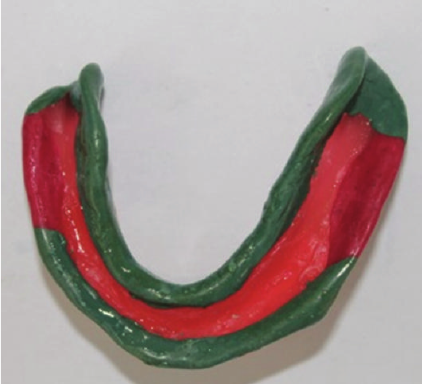
Figure 10: Custom tray with complete mandibular border mould- ing.